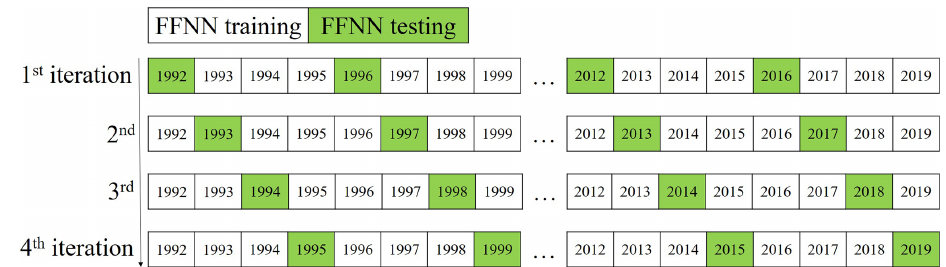
Figure 3. The K -fold validation procedure. (The K value was set as 4, so iterations were repeated 4 times until all samples were set as having tested samples once. In each iteration, samples in 7 years were set as testing samples (green cells) and in the rest 21 years were set as training samples (white cells) to increase